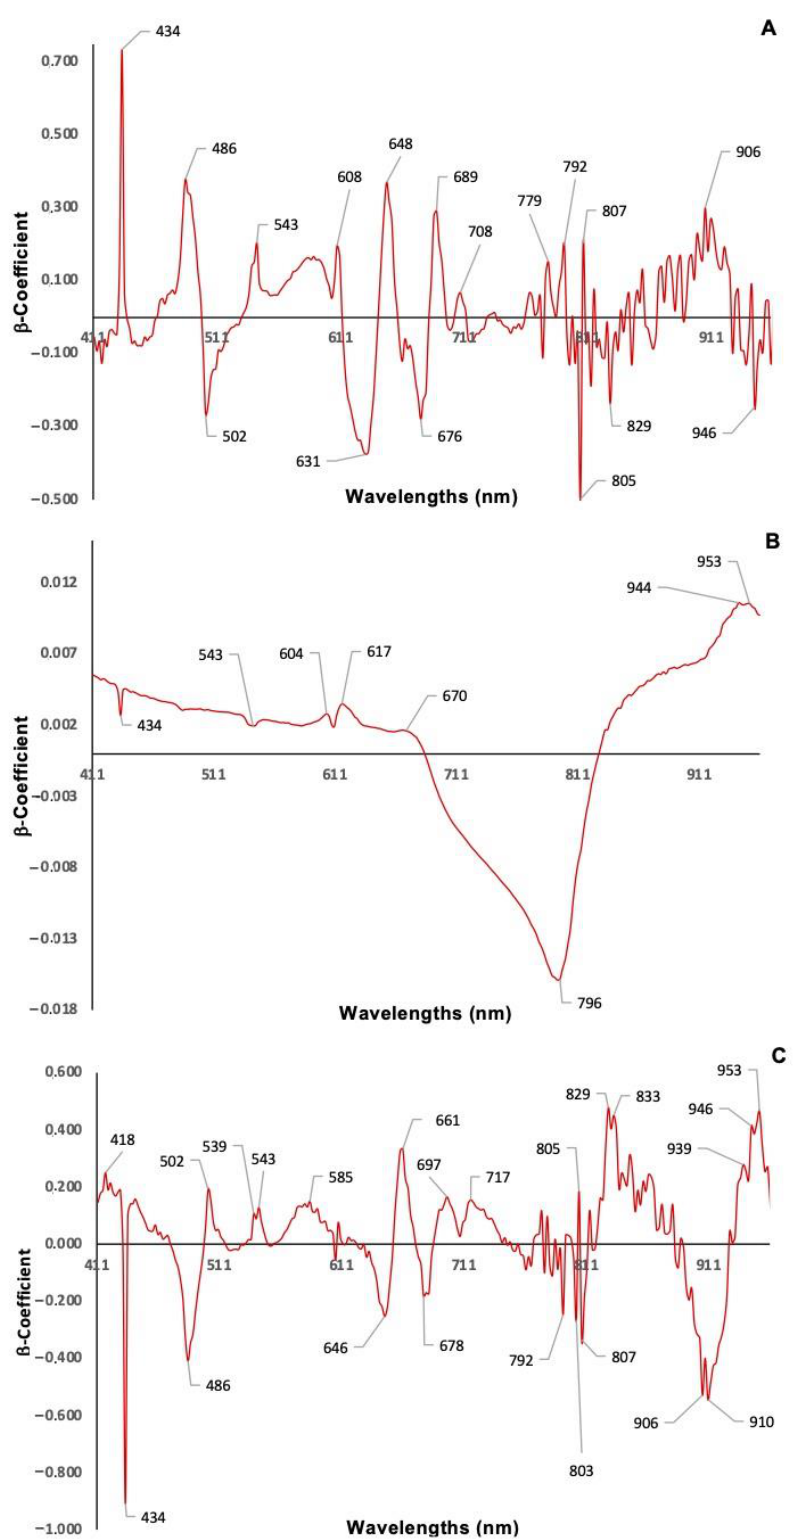
Figure 4. Values of β -coefficients for all wavelengths for predicting quality attributes in table grape for the quality attributes, Total Flavonoids ( A ), Total Anthocyanins ( B ), and Total Soluble Solids (TSS) ( C ).